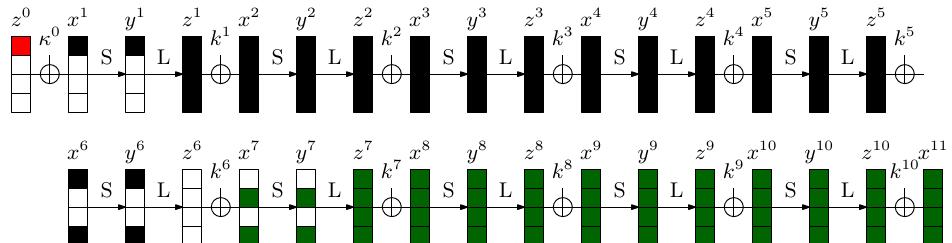
Figure 10: Generalized Demirci-Selçuk attack on 10 round version of